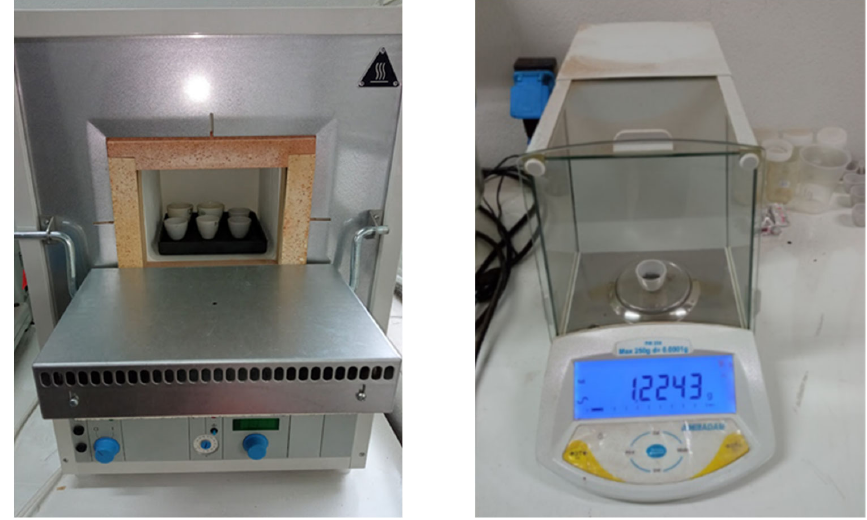
Figure 5. Drying of soil samples in a heating chamber and a scale of high accuracy (4 decimal places) for weighing the samples.